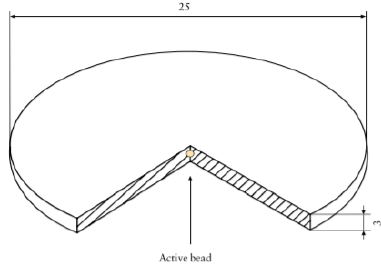
Figure 3. Schematic view of the radioactive housing